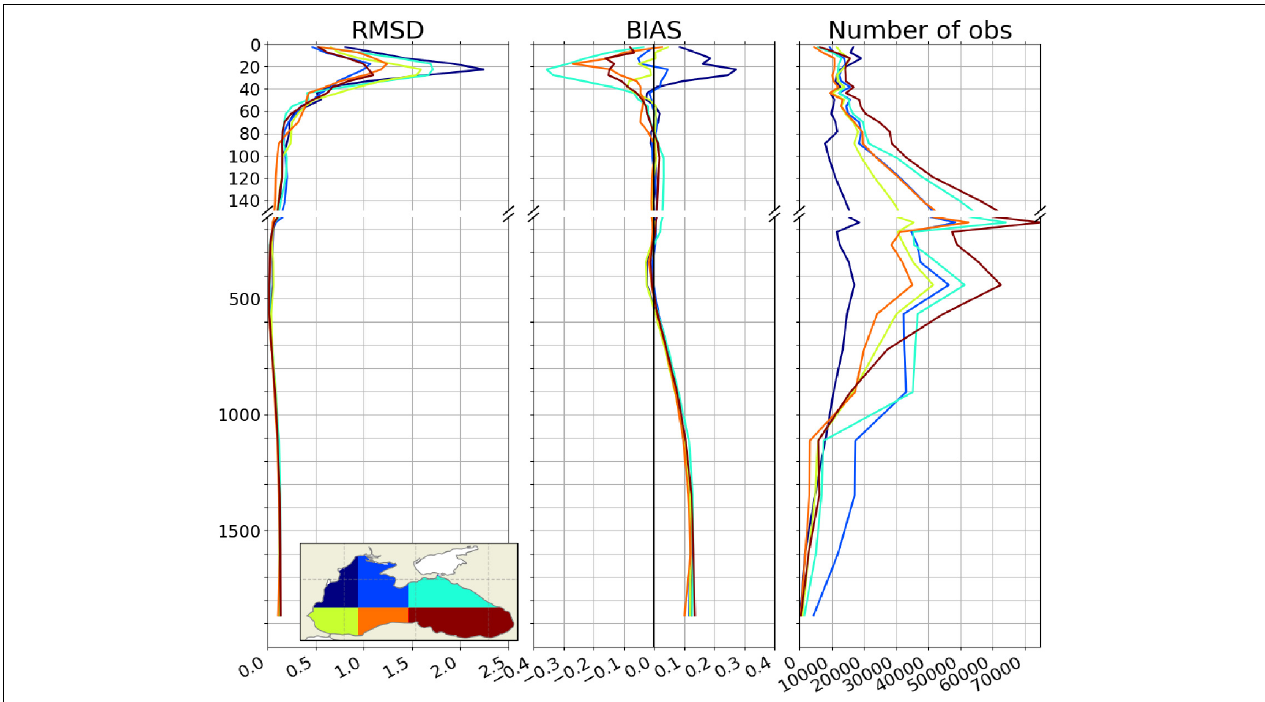
FIGURE 3 | Vertical profiles of the root mean square deviation (left panel), bias (middle panel), and number of observations (right panel) for temperature ( ◦ C) for different subdomains in the Black Sea, by comparing the BS-REA results against in situ profilers in the Black Sea domain from 1 January 1993 to 31 December